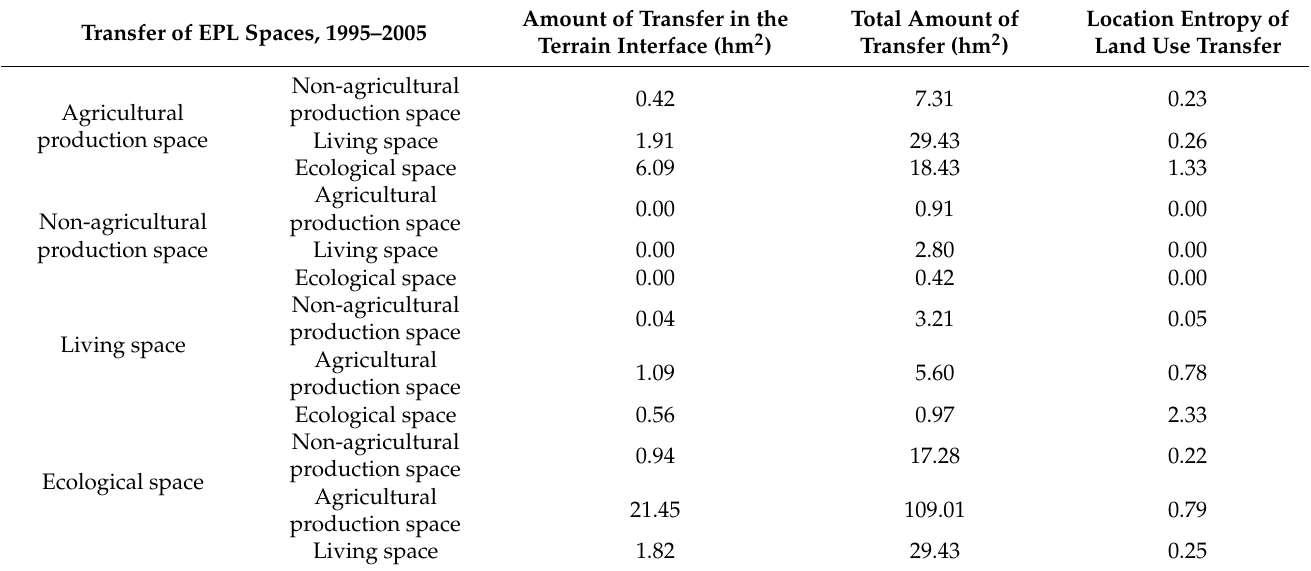
Table 5. Spatial transfer of EPL spaces in the terrain interface area from 1995 to